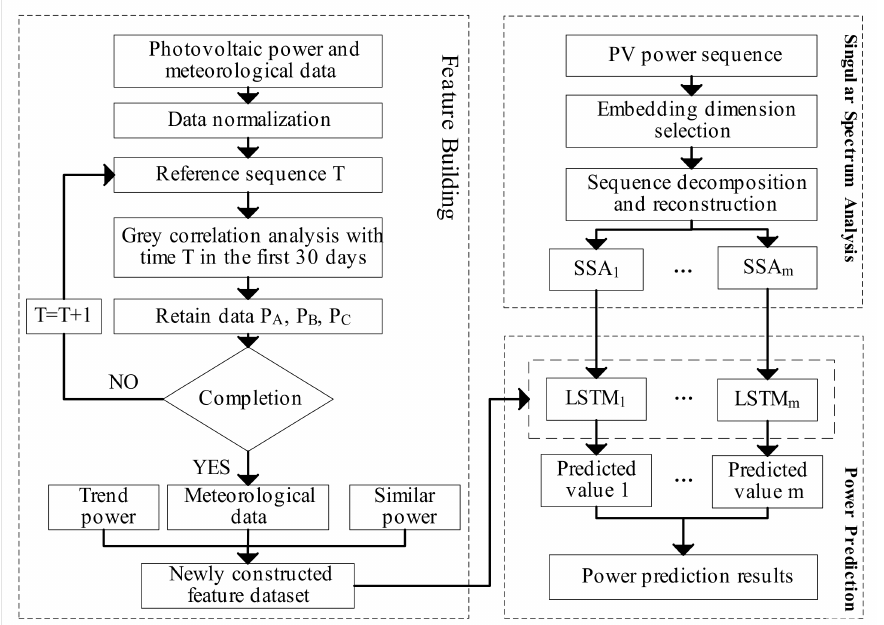
Figure 4. Flowchart of the combined forecasting